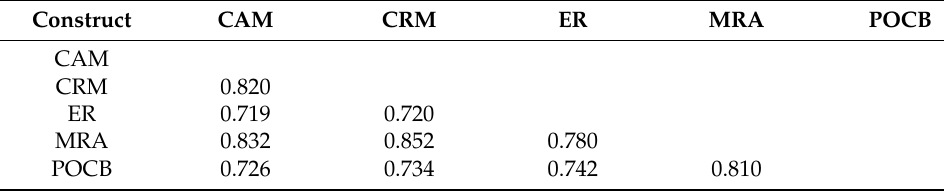
Table 5. Discriminant validity using HTMT criterion.